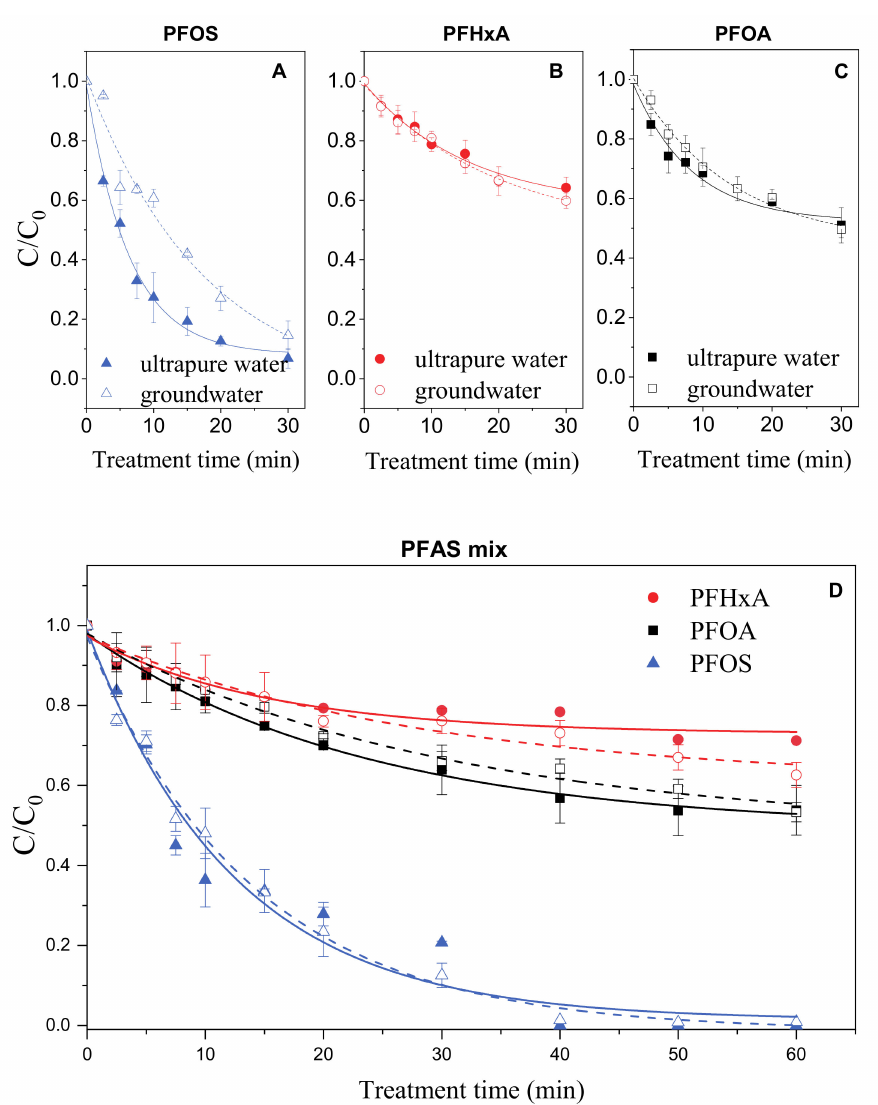
Figure 6. Degradation of pefluorooctanesulfonic acid (PFOS) ( A ), perfluorohexanoic acid (PFHxA) ( B ) and perfluorooctanoic acid (PFOA) ( C ) treated individually in ultrapure and groundwater matrices. Degradation of perfluoroalkyl substances (PFAS) treated in mixture ( D ) in ultrapure (solid symbols, solid lines) and groundwater (open symbols, dashed